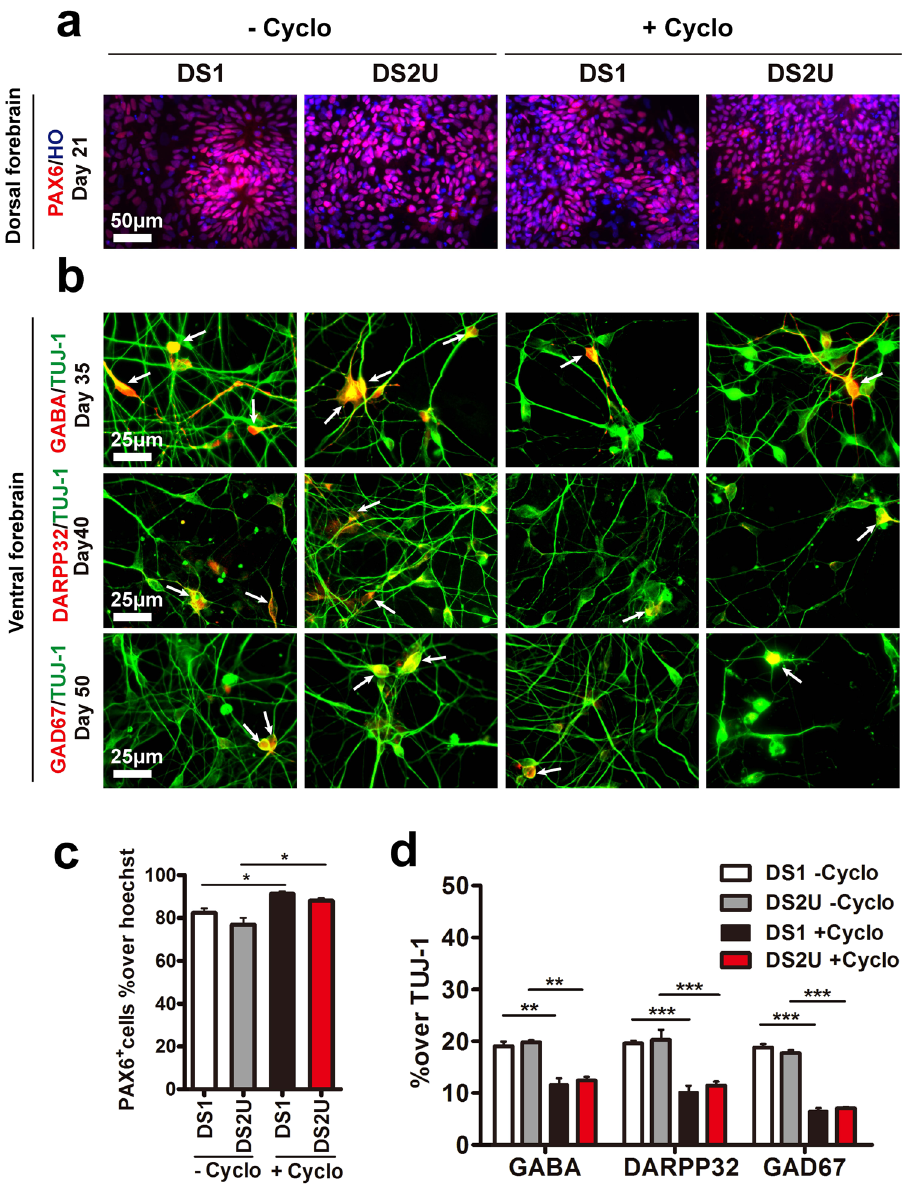
Figure 4. Application of cyclopamine inhibited the ventral patterning from Down Syndrome patient-iPSCs. ( a ) Expression of marker for dorsal forebrain (PAX6) from d21. Scale bar, 50 μ m. ( b ) Expression of markers for ventral forebrain neurons (GABA, DARPP32, GAD67) (arrows) from d35. Scale bar, 25 μ m. ( c ) Proportion of PAX6 + cells in total cells. * p < 0.05. More than 1,500 cells from random fields were manually counted in each condition. The data are presented as the mean ± s.e.m, n = 3 in each condition. ( d ) Significantly fewer GABAergic related neurons in cyclopamine treatment groups. ** p < 0.01; *** p < 0.001. More than 500 neurons from random fields were manually counted in each condition. The data are presented as the mean ± s.e.m, n ≥ 3 in each